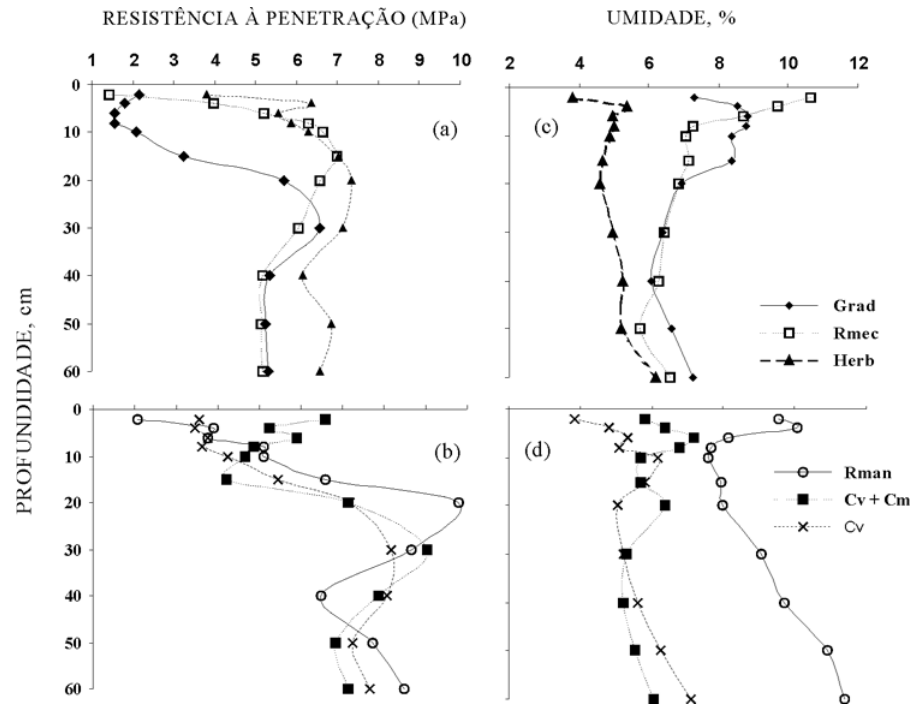
Figura 1. Curvas de resistência à penetração (a e b) e umidade (c e d) de um Argissolo submetido a diferentes sistemas de manejo com a cultura do cajueiro anão precoce, no município de Pacajus, CE. Grad: gradagem + coroamento; Rmec: roçagem mecânica + coroamento; Rman: roçagem manual + coroamento; Cv: cobertura vegetal + coroamento; Cv + Cm: cobertura vegetal + cobertura morta; Herb: aplicação de herbicida (média de três